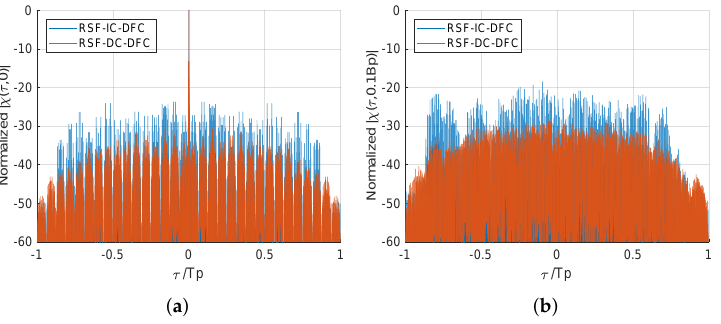
Figure 6. Comparison of RSF-IC-DFC and RSF-DC-DFC in different Doppler profiles: ( a ) 0-Doppler profile; ( b ) 0.1 B p -Doppler profile.